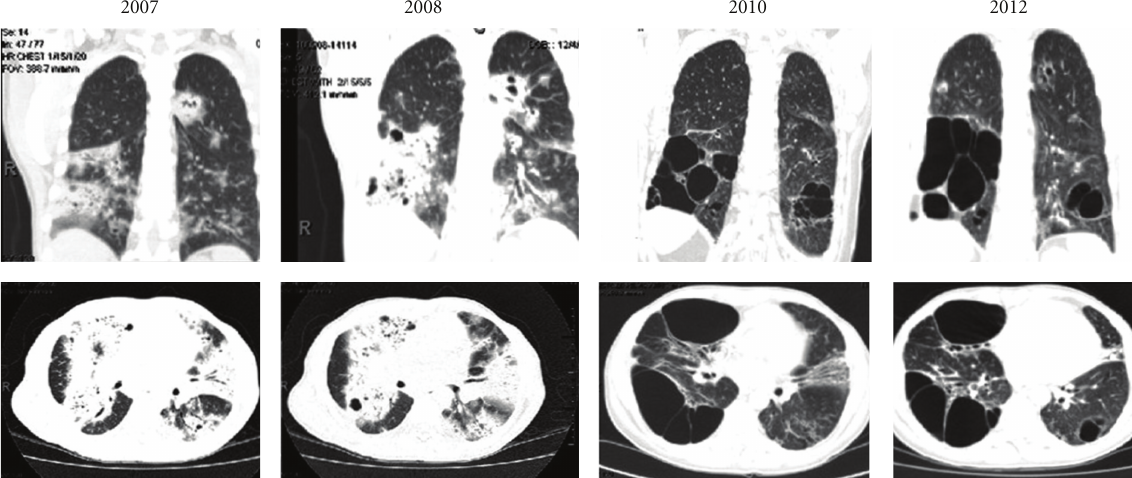
Figure 3: Serial chest computed tomograms showing progressive replacement of areas of lymphomatous interstitial infiltrates with bullous